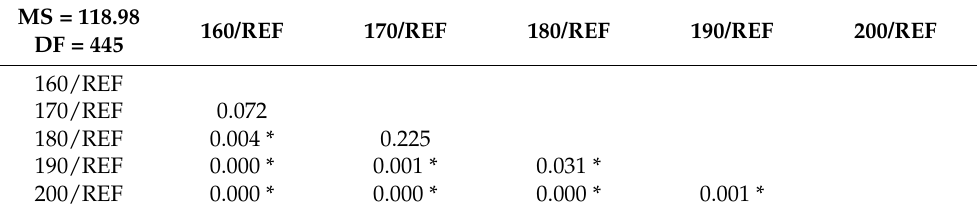
Table A5. Duncan ´ s multiple range test for changes in volume heat capacity.